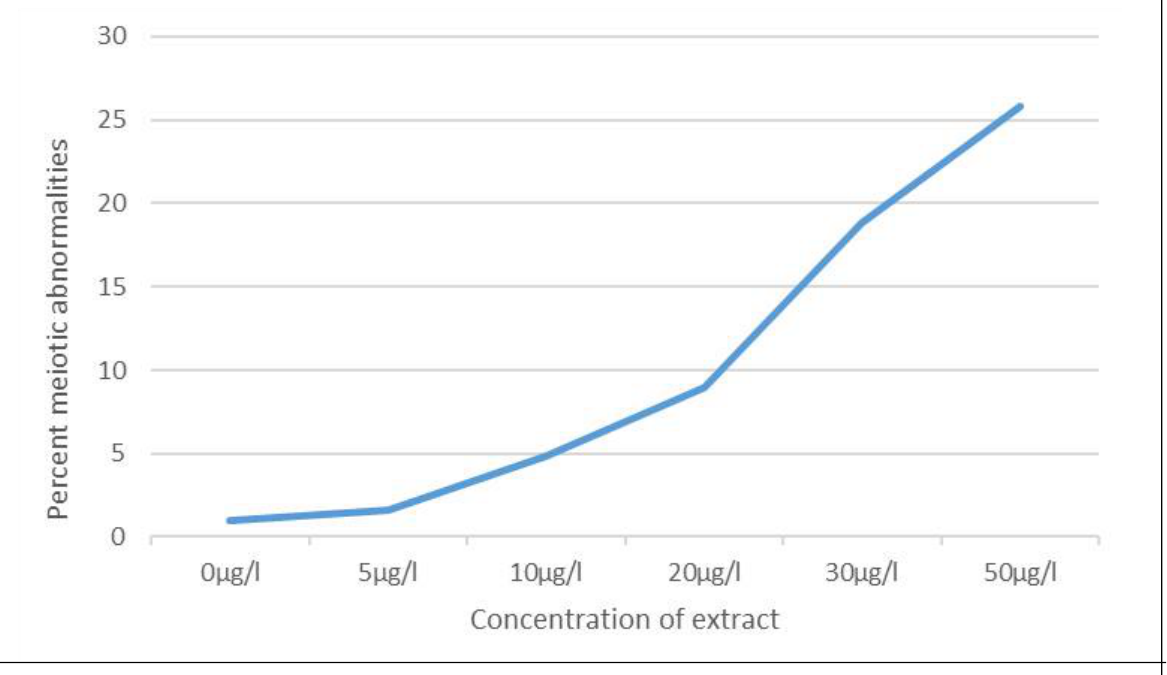
Figure 2: Relationship between different concentrations of aqueous leaf extract of watermelon ( C. lanatus ) and meiotic chromosome abnormalities induced in Z. variegatus